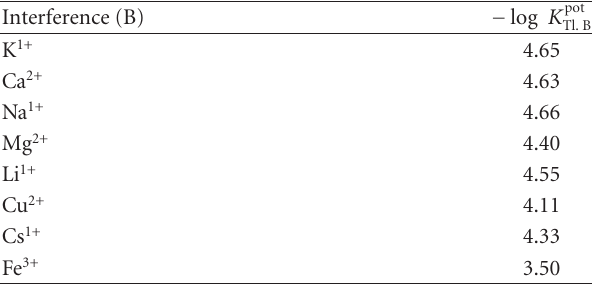
Table 1: The logarithm of the selectivity coe ffi cient of the thallium ion sensor for di ff erent interferents in 1 × 10 − 4 M.